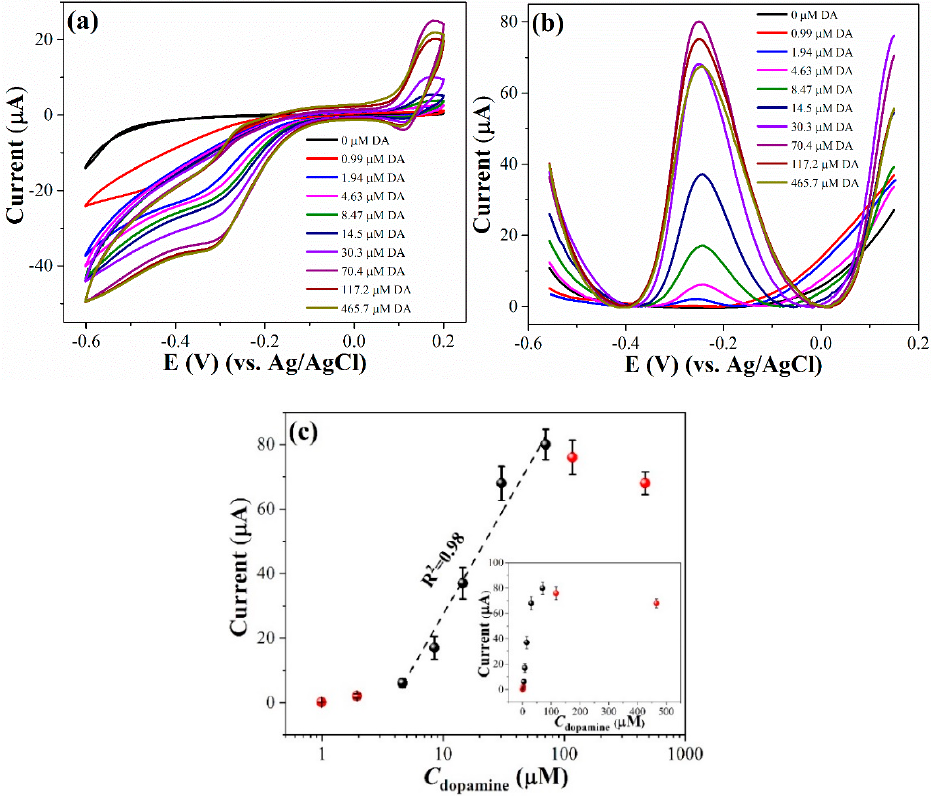
Figure 1. ( a ) Cyclic voltammetry curves and ( b ) square wave voltammetry (SWV) current responses of split aptamer-based electrochemical sandwich assays for the detection of different dopamine concentrations; ( c ) dependence of the electrochemical current on dopamine concentration.